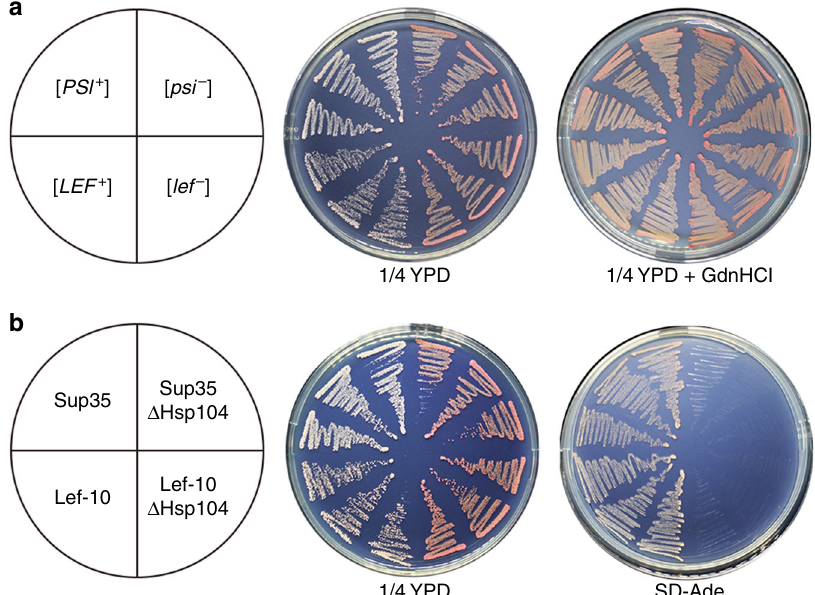
Fig. 3 The [ LEF + ] phenotype in yeast is Hsp104-dependent. a Phenotypic curing of [ LEF + ] by guanidine hydrochloride (GdnHCl), an inhibitor of molecular chaperone Hsp104. Phenotypes of [ PSI + ], [ psi - ], [ LEF + ], and [ lef - ] colonies were, respectively, re-streaked on 1/4 YPD medium with or without 5 mM GdnHCl. b The [ LEF + ] strain phenotype is curable by deletion of the HSP104 gene. The [ PSI + ] strain was used as